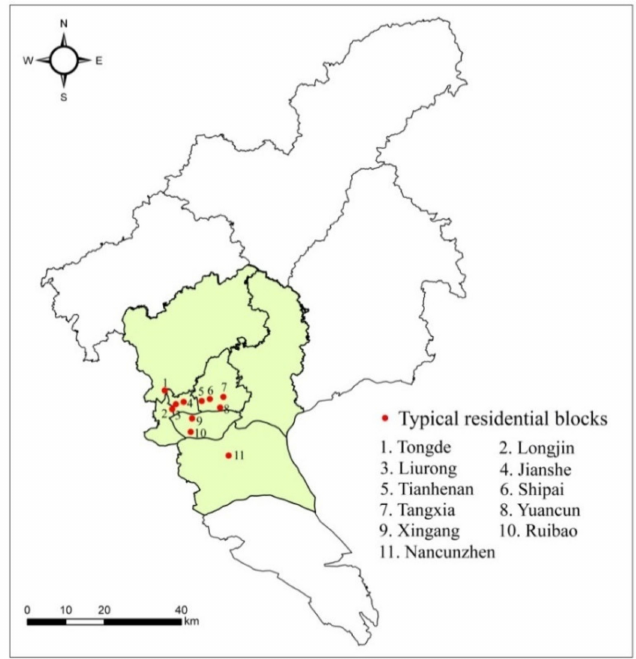
Figure 2. Study area and typical residential